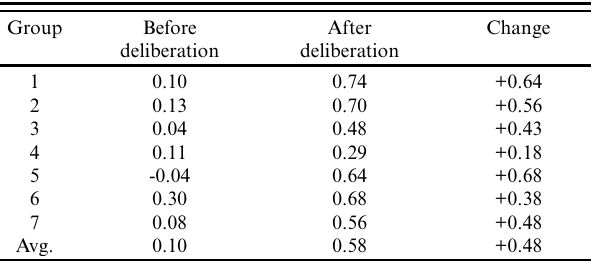
Table 6 . Kendall correlations between individual rankings and deliberative rankings, averaged by group.